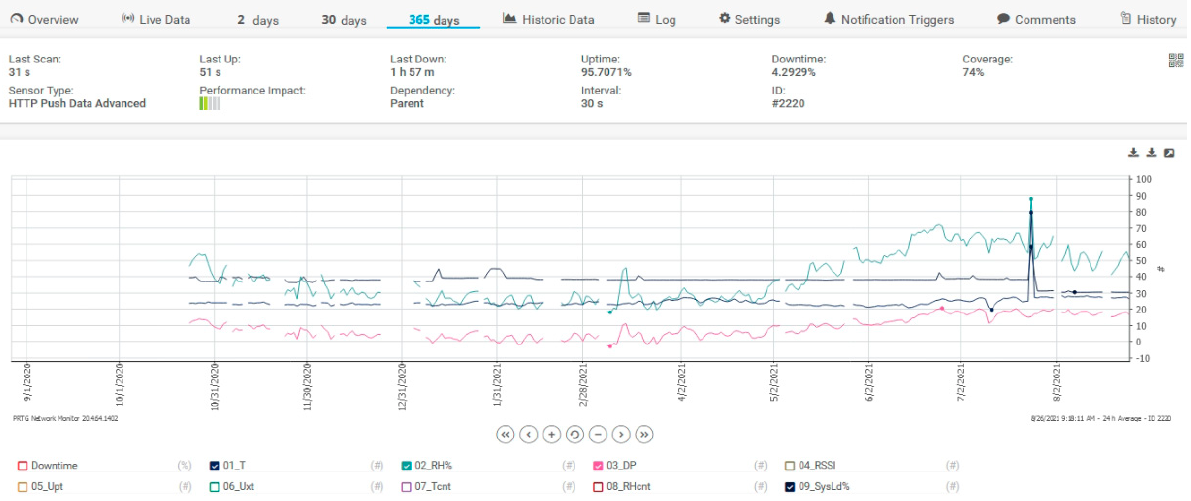
Figure 14. PRTG Server data for temperature, humidity, dew point and SysLoad.